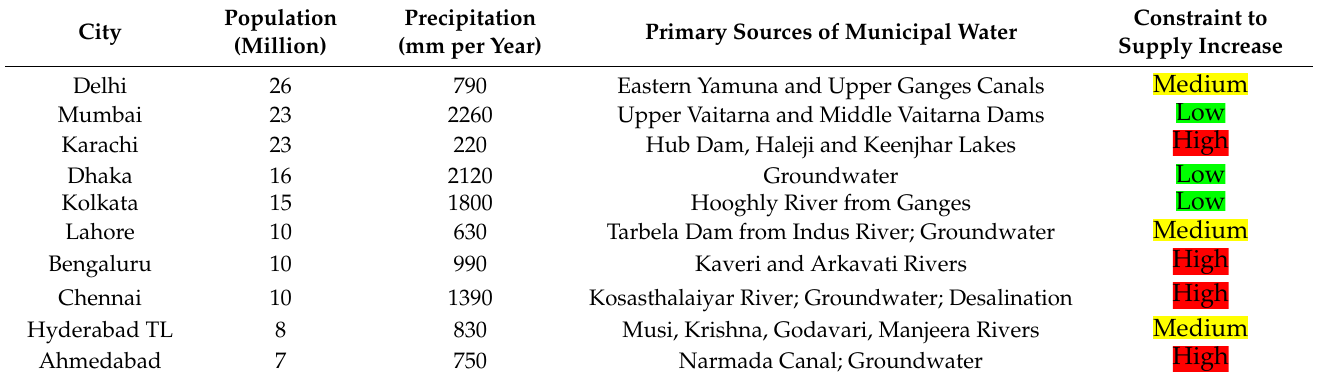
Table 1. Characteristics of the ten largest cities of South Asia and their municipal water supplies.